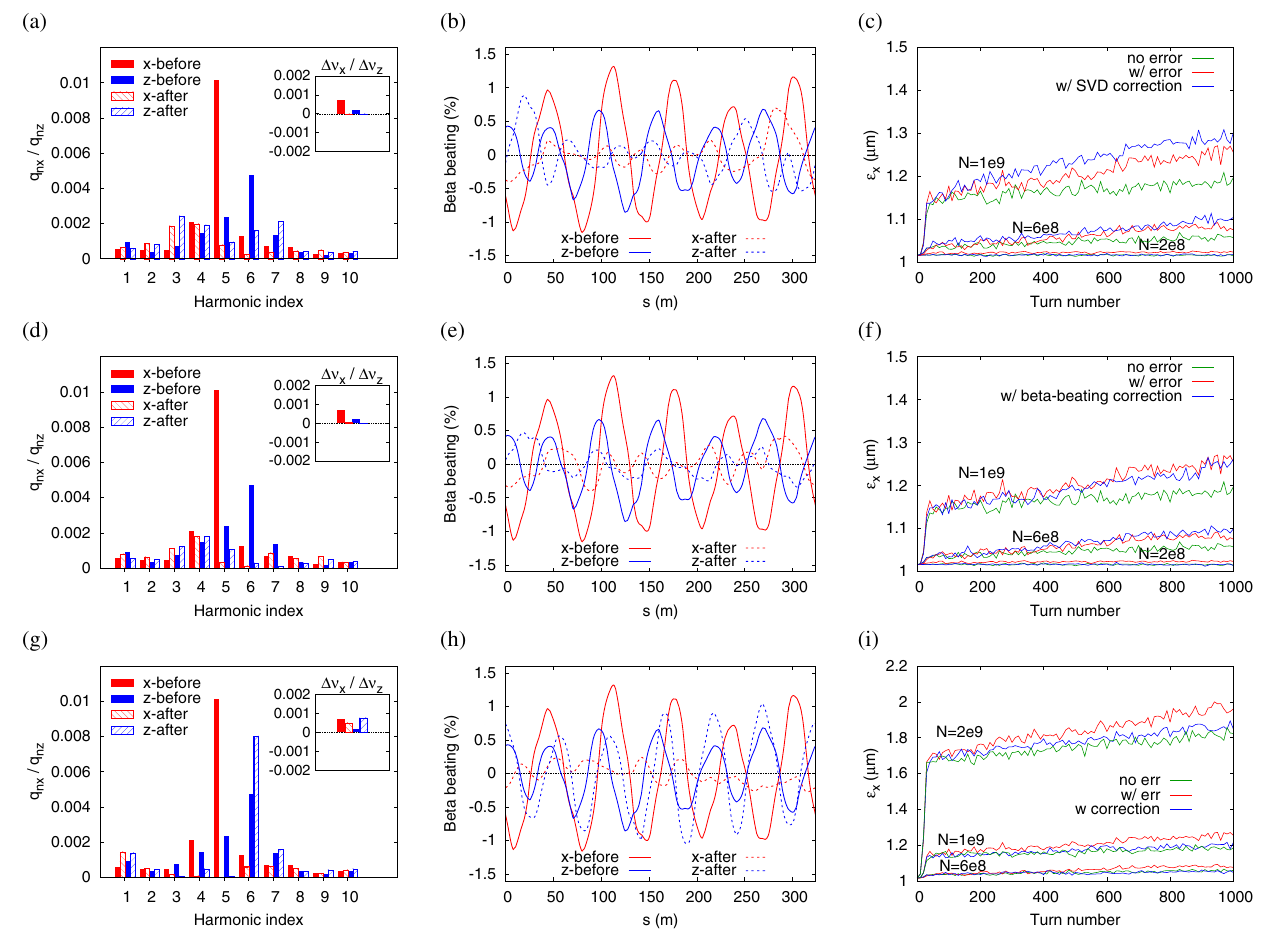
FIG. 9. The stop band harmonics, betatron tunes shift, beta function beating, and emittance growth in 1000 turn before and after correction (a) – (c) by stop band harmonics correction with SVD, (d) – (f) by beta-beating correction with SVD, and (g) – (i) by stop band harmonics correction with other methods. ( ν x ¼ 2 . 6 , ν z ¼ 2 . 9